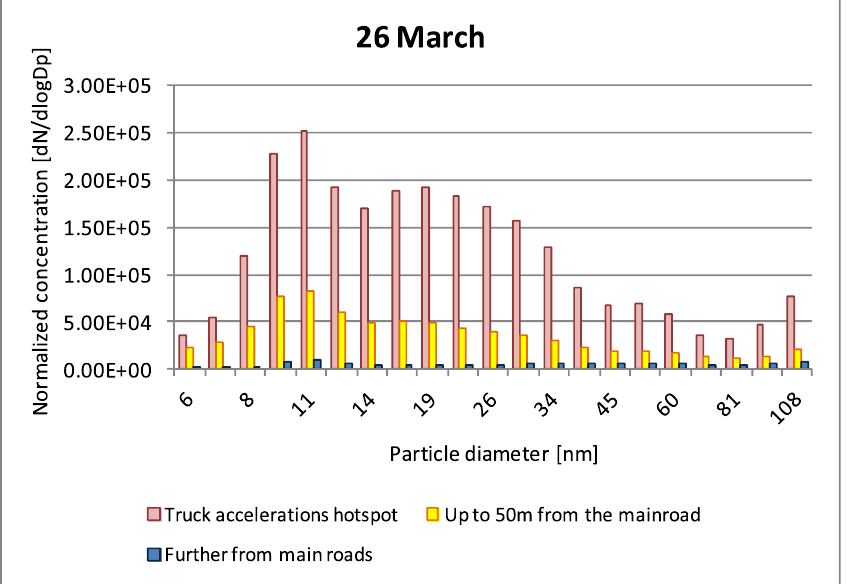
Figure 11. Particle number distributions near a hotspot and around according to distance from the hotspot and a main road measured in Sporilov on 26 March; Truck accelerations hotspot showed bimodal distribution with peaks at 10 and 20 nm. There should probably be another peak in larger particles; however, those data are not available because of the contamination of the corresponding instrument channels. Particles concentrations decreased with the distance from the road (up to 50 m), while the size distribution